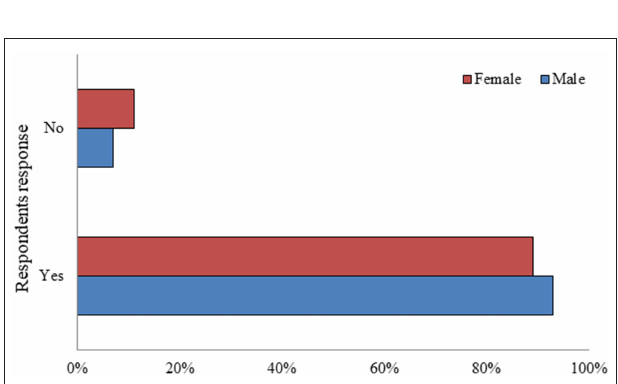
FIGURE 2 | Gender-wise comparison of social media use among the study participants ( n = 726).